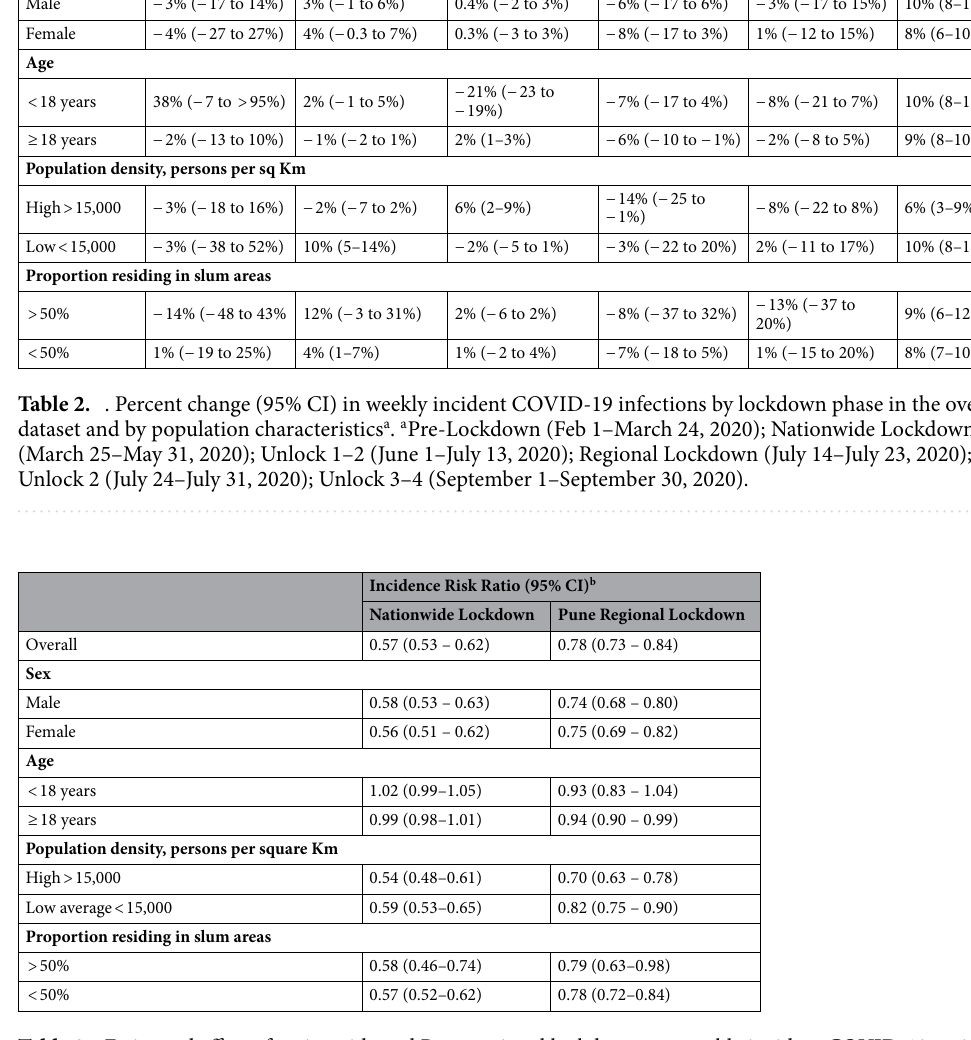
Table 3. Estimated effect of nationwide and Pune regional lockdowns on weekly incident COVID-19 patients using Poisson regression in Pune India, overall and by population characteristics a . a Pre-Lockdown (Feb 1